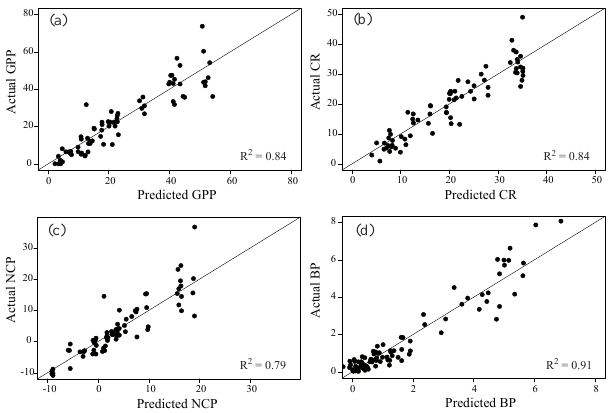
Figure 3. Comparison of actual values and values predicted by the mixed-effects model for (a) gross primary production (GPP), (b) community respiration (CR), (c) net community production (NCP) and (d) bacterial diversity. Black solid line represents the 1 : 1